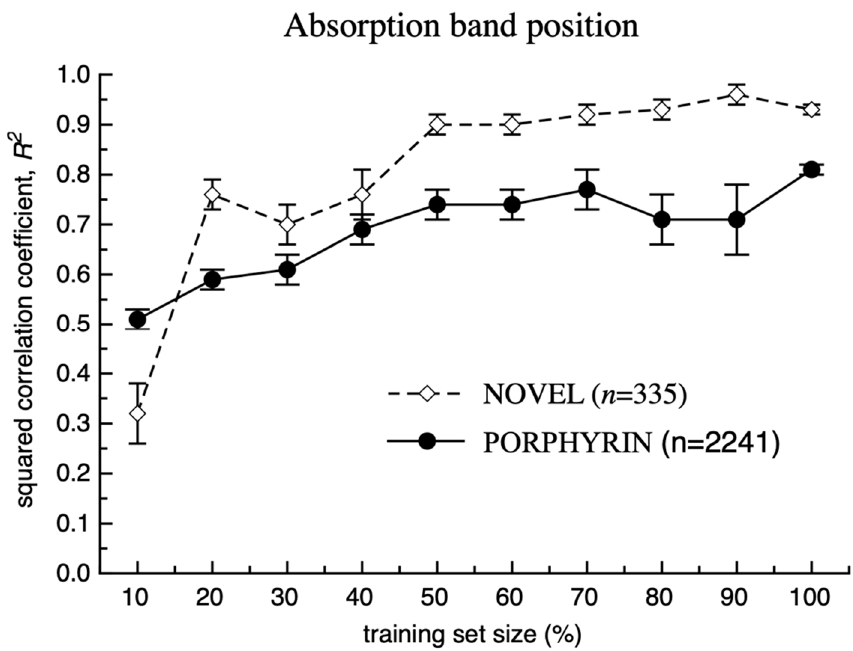
Figure 6. Statistical coefficients calculated for the prediction of the test set compounds that were not part of the respective training sets for modelling of the absorption band maximum position (see also Supplementary Data, Tables S5 and S6). 5CV values were reported for 100% training set size.